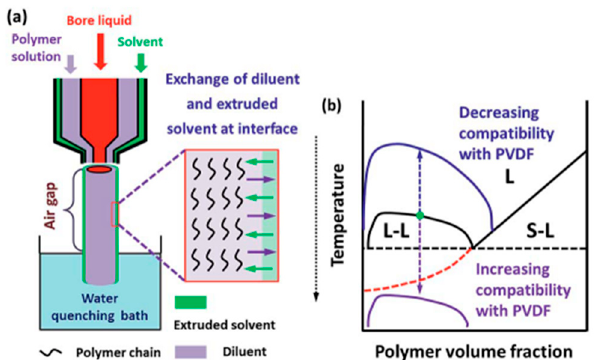
Figure 4. Interfacial behavior of the diluent or polymer chains ( a ) and the change in the phase separation ( b ) during membrane formation in the presence of extruded solvents having different compatibilities with the polymer at the outer surface. S and L are the solid and liquid, respectively. Adapted from reference [171]. [A color figure can be viewed in the online issue, which is available at wileyonlinelibrary.com.].